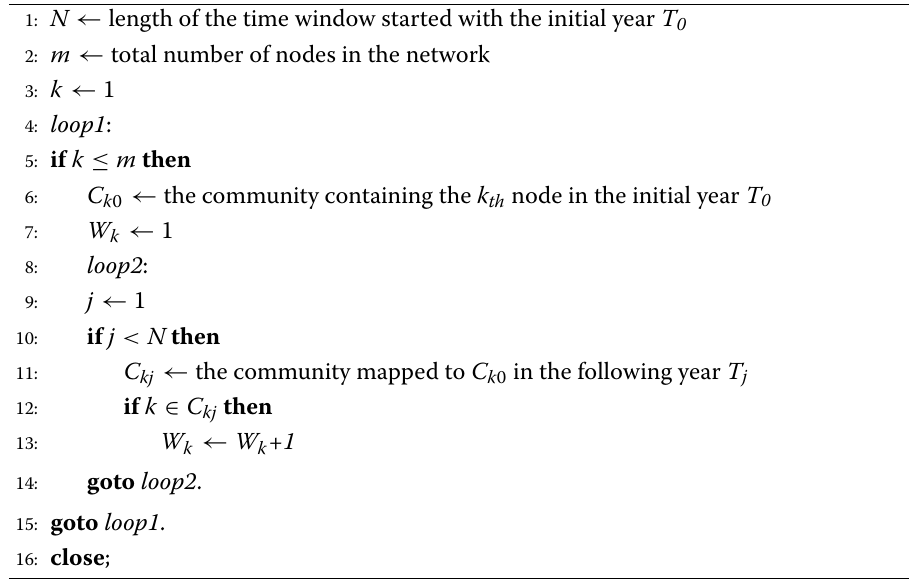
Algorithm 2 Pseudo-code of Central Nodes